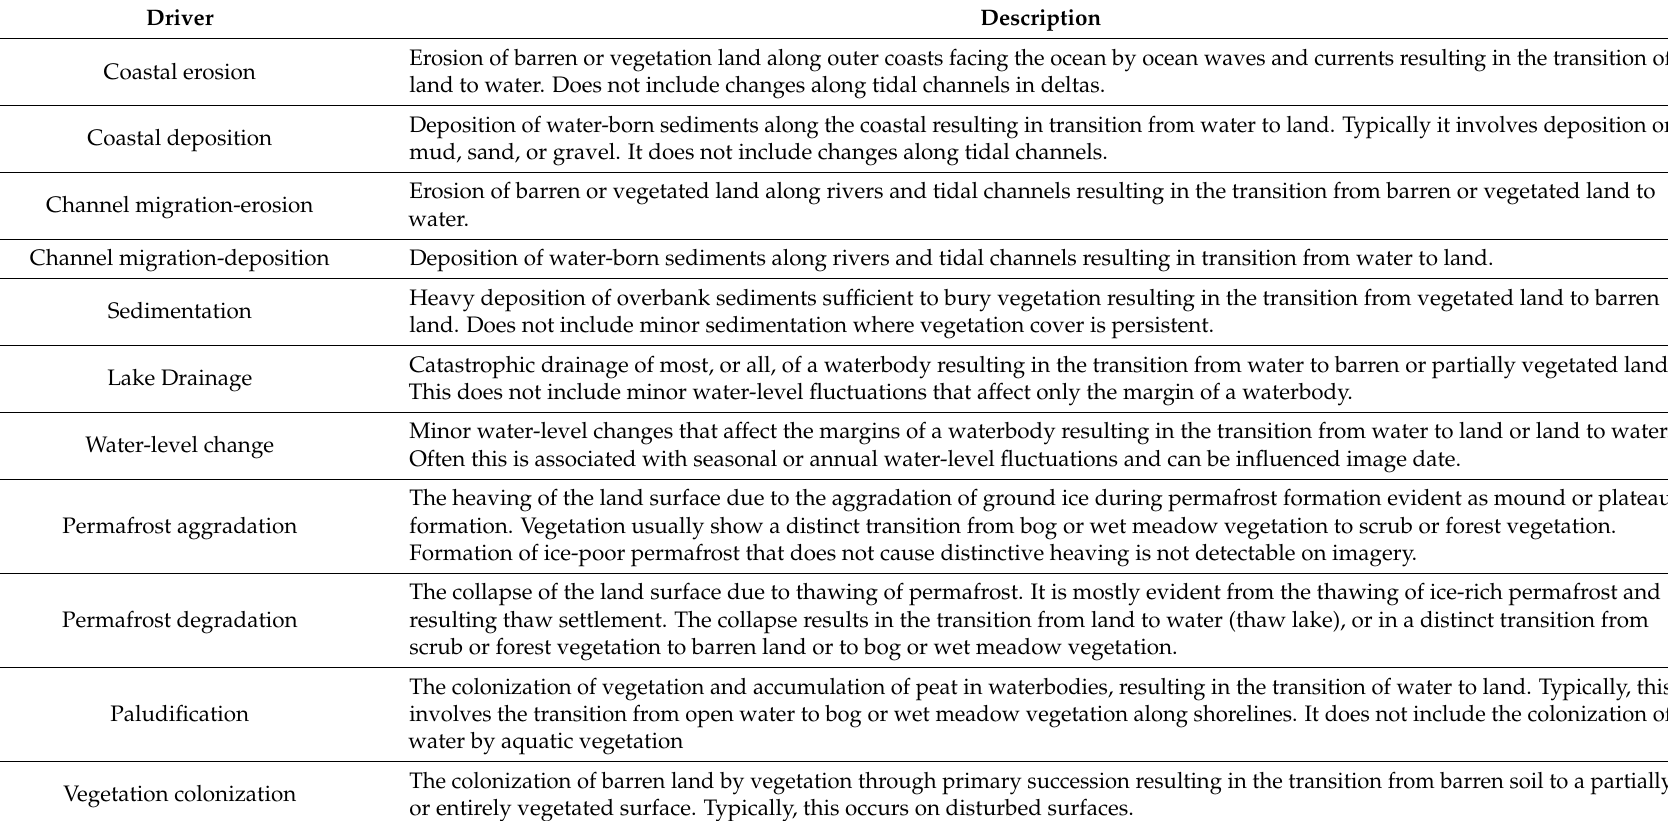
Table A3. Description of geomorphic and biological drivers of landscape